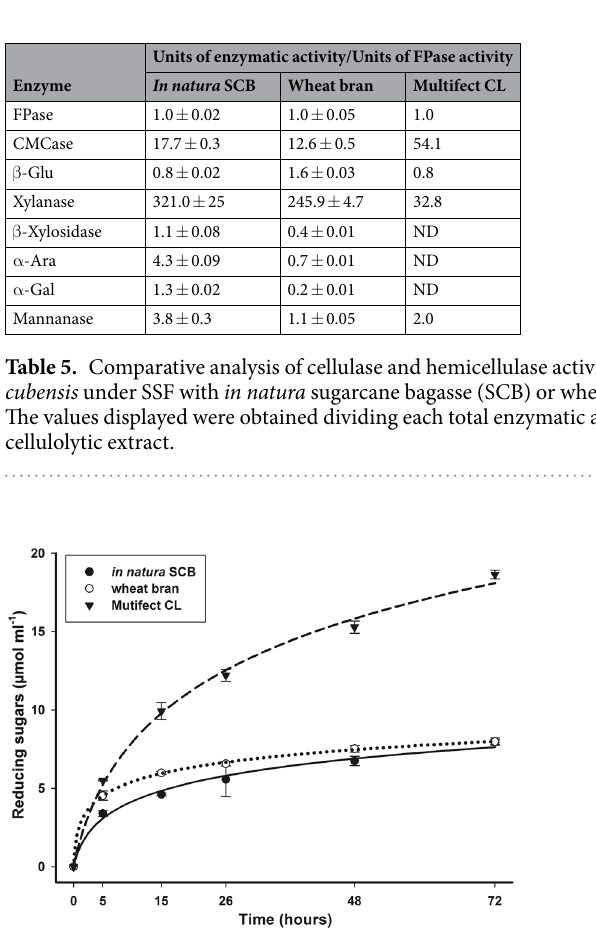
Figure 1. Production of reducing sugars per time by enzymatic saccharification of microcrystalline cellulose Avicel using extracts produced by Chrysoporthe cubensis under SSF with in natura sugarcane bagasse (SCB) ( ● ) or wheat bran ( ○ ) and commercial extract Multifect CL ( ▼